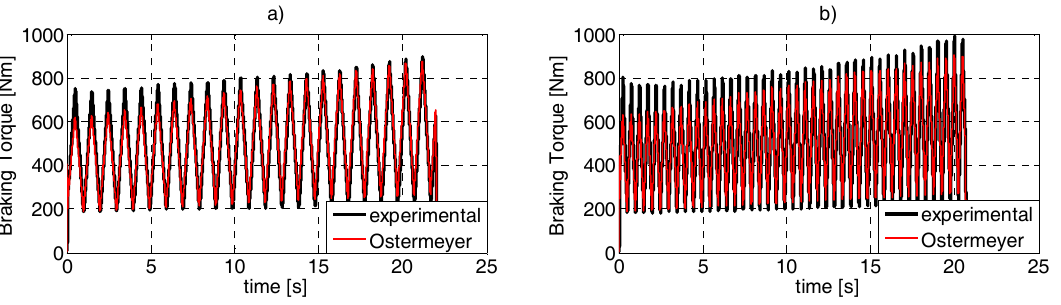
Figure 5. ( a ) Results of the identification process (first dataset); ( b ) results of the validation process (second dataset). Comparison between the experimental and the model-predicted braking torque.